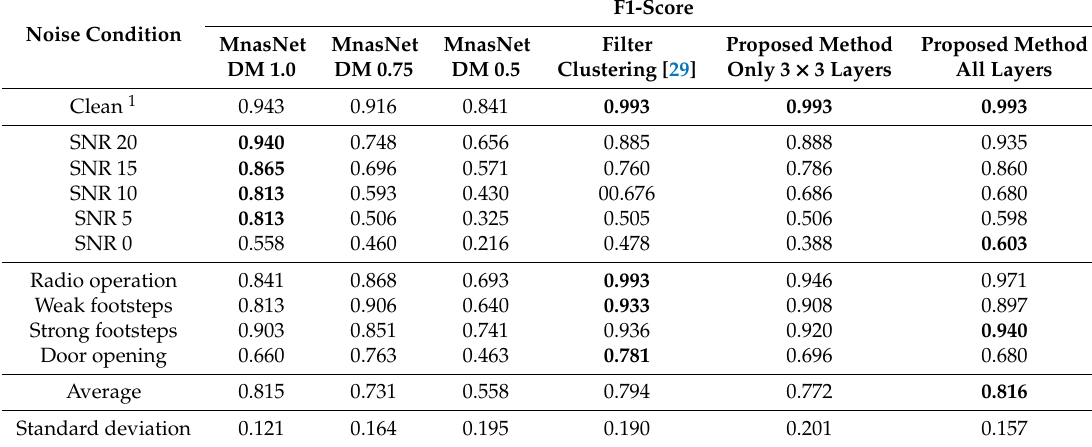
Table 3. Sound-based pig abnormality identification results (Train: clean